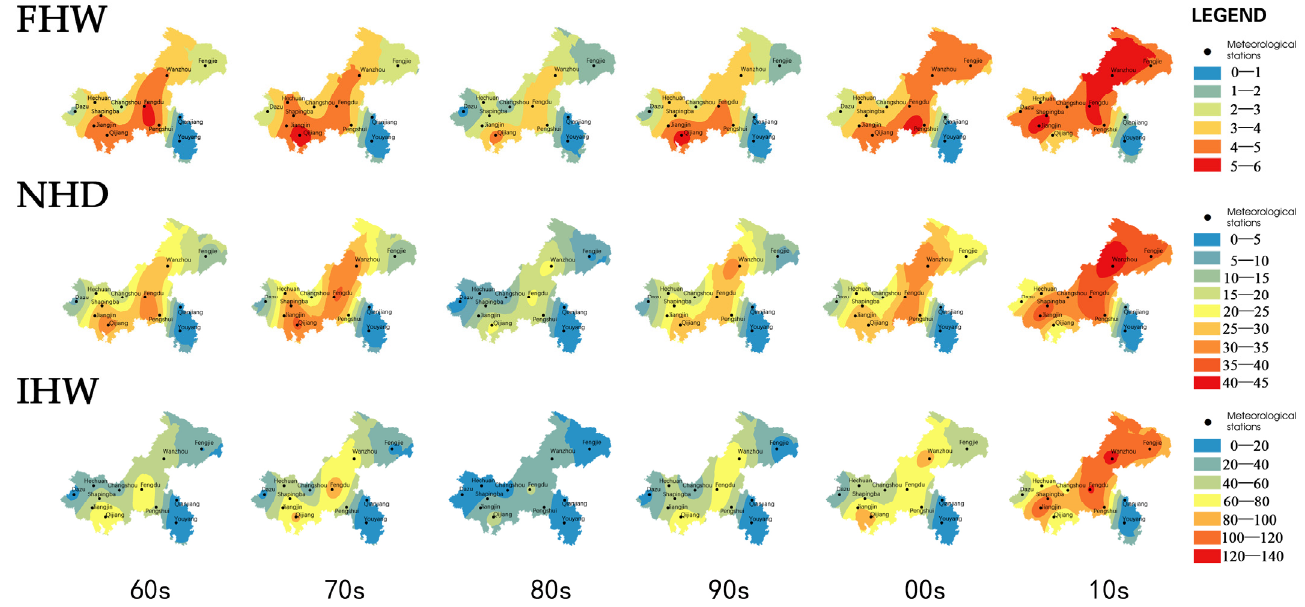
Figure 7. Spatial distribution of FHW, NHD, and IHW of interdecadal high-temperature heat waves at various meteorological stations in Chongqing.